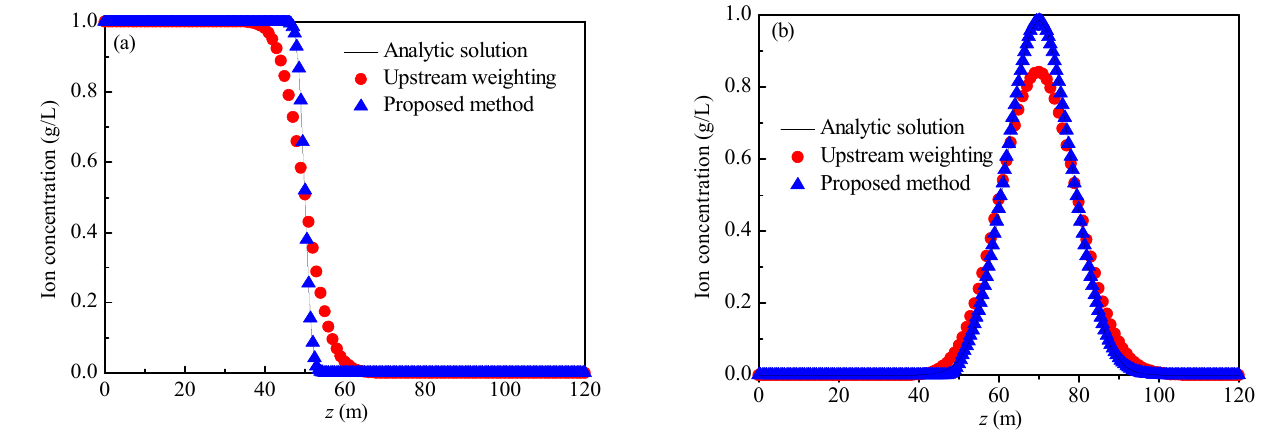
Figure 8. Breakthrough curves: ( a ) Example 1; ( b ) Example 2.